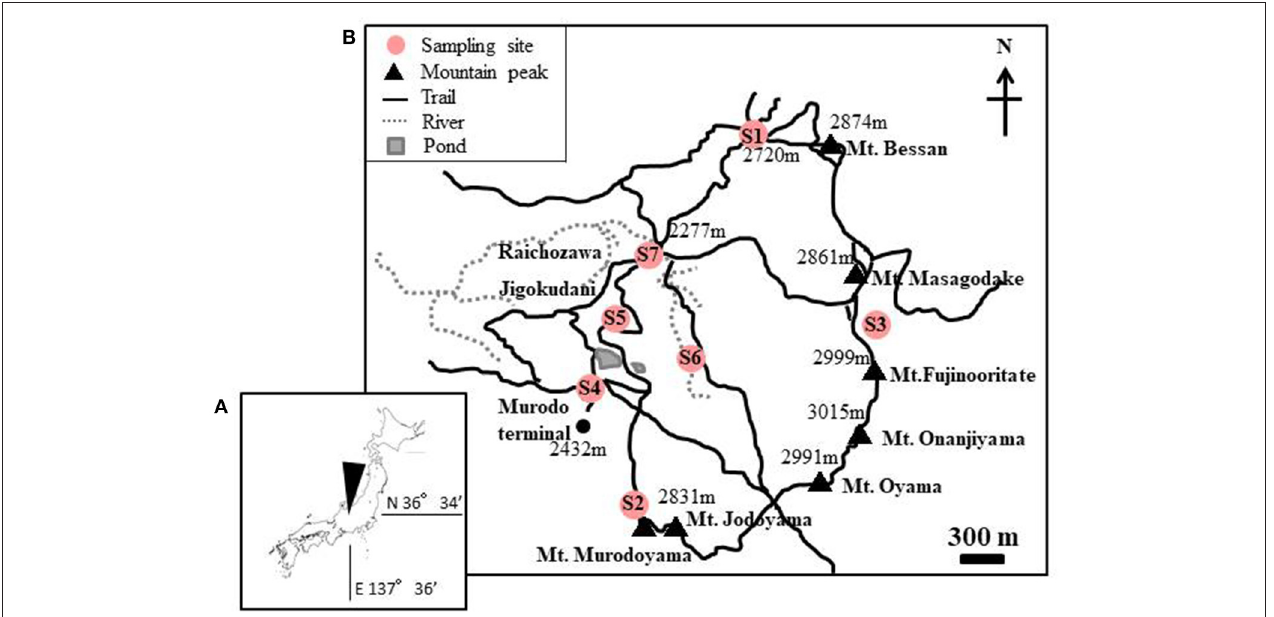
FIGURE 1 | (A) Maps showing the location of the study area in Mt. Tateyama, Japan. (B) Locations of the sites where the red snow samples were collected. Numbers in the map indicate the altitude above sea